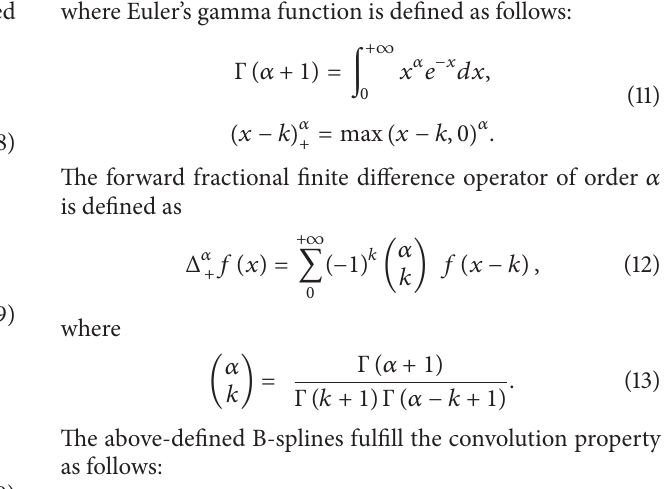
is defined as 𝑝 = 𝑚−𝑛−1 . The knots 𝑡 𝑝+1 , . . . , 𝑡 𝑚−𝑝−1 are